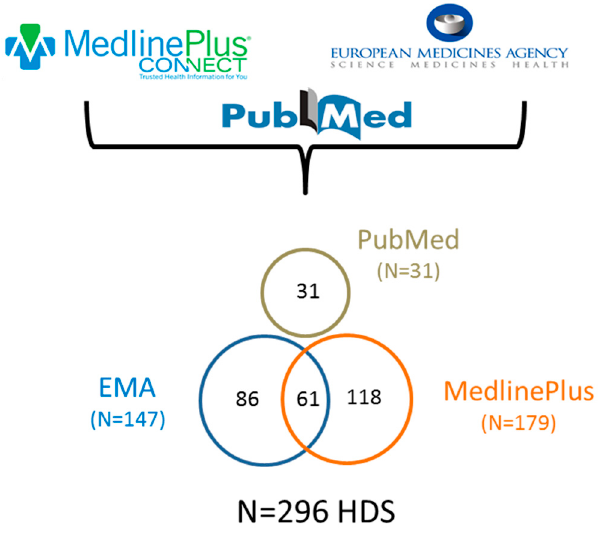
Figure 2. Data sources for the collection of 296 herbal and dietary supplements (HDS) evaluated for hepatotoxicity.